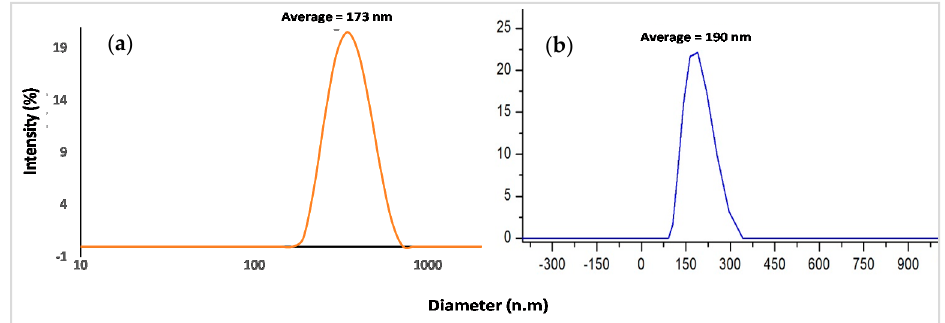
Figure 8. ( a ) Size distribution of chiral PMO nanoparticles (NPs) and ( b ) Size distribution of magnetic chiral PMO NPs.